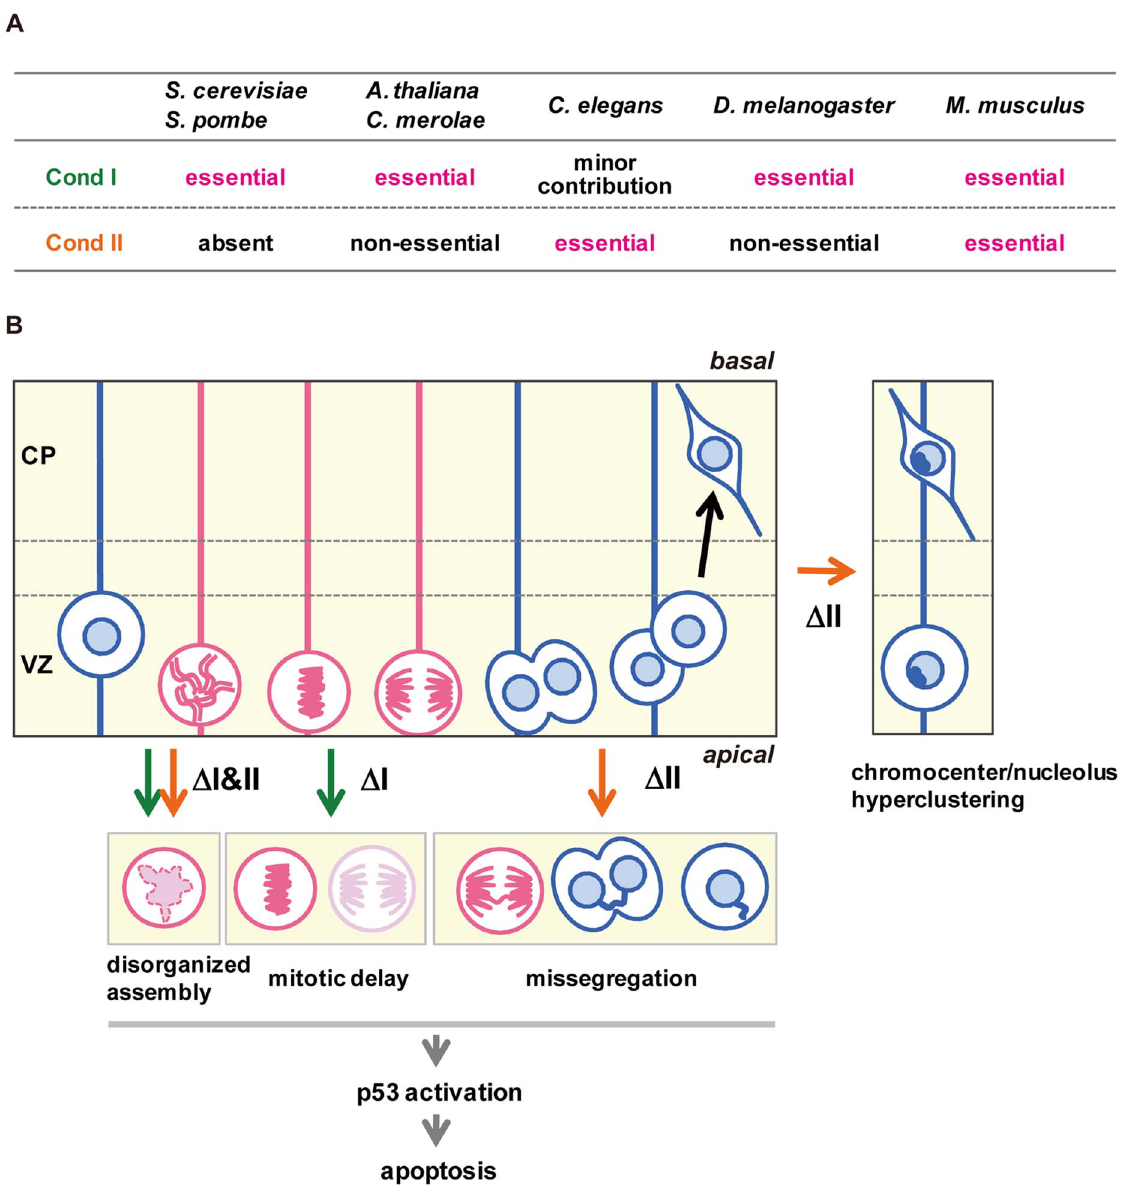
Figure 7. Functional diversity of condensins I and II in evolution and during brain development. ( A ) Requirements of condensins I and II for mitotic cell divisions differ among different model organisms. ( B ) Summary of defective phenotypes observed in NSCs depleted of condensin I, condensin II or both. See the text for details.